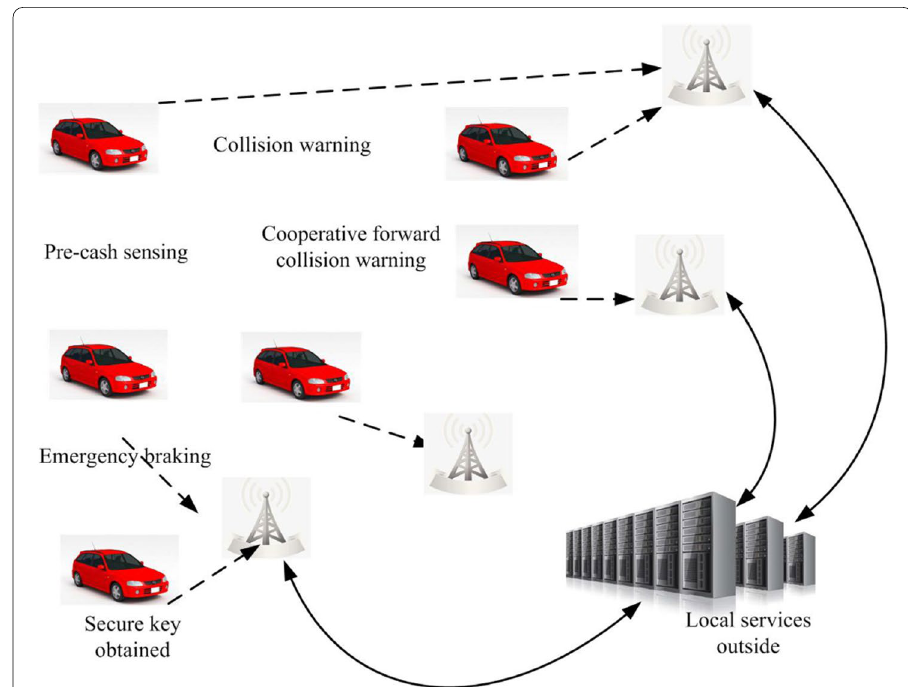
Fig. 1 Network of smart traffic information